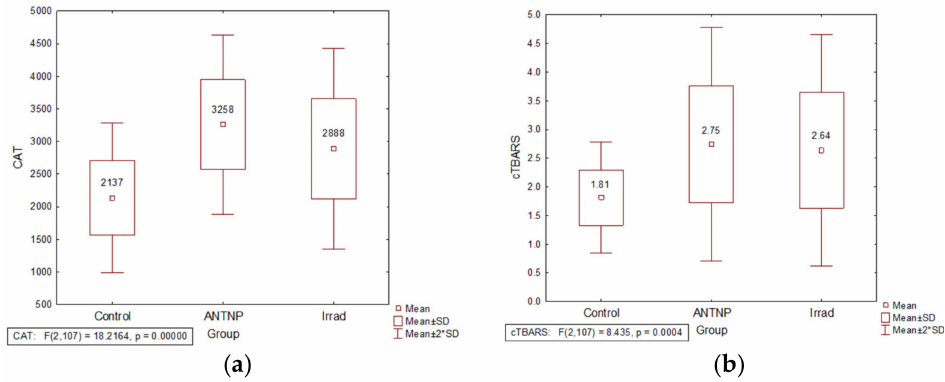
Figure 2. The impact of occupational exposure on oxidative stress parameters: ( a ) catalase activity (U/g Hgb); ( b ) cTBARS (nmol of MDA/L). Control—unexposed volunteers; ANTNP—workers exposed to antineoplastic drugs; Irrad—workers exposed to ionizing irradiation.